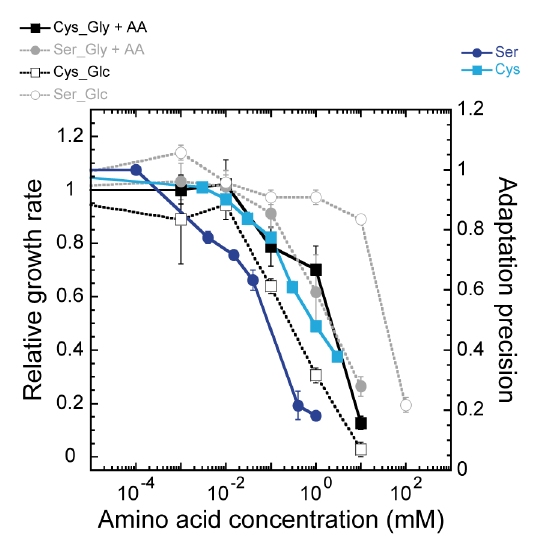
Figure 3. Inhibition of E.coli growth by serine and cysteine. E. coli MG1655 cells were grown at 34 u C in M9 minimal medium [29] supplemented with 10 m g/ml thiamine and either 0.4% glycerol and four amino acids (Gly + AA) or 0.4% glucose (Glc). Indicated amounts of L-serine or L-cysteine were added after 2 hours of growth. Relative growth rate was determined as the difference between the optical density of the culture at 600 nm after 3.5 h and 5 h of growth, normalized to the value of a control culture grown without serine or cysteine. Adaptation precision for serine and cysteine was replotted from Fig.